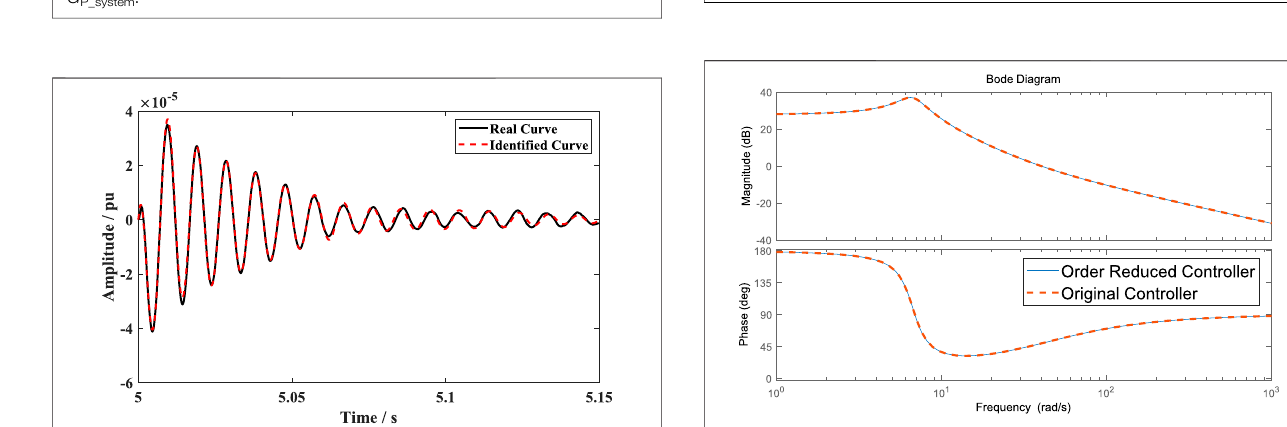
FIGURE 12 | Controllers K P_system (s) with and without reduction.